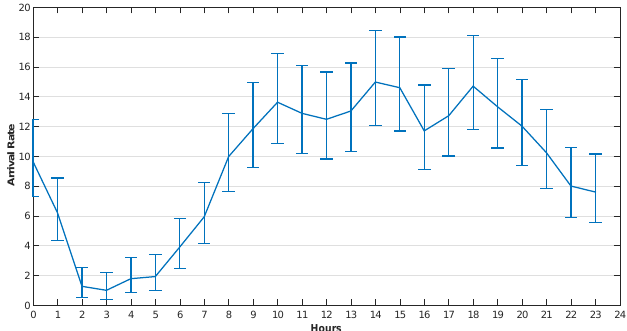
Figure 5. The Arrival Rate in 24 h, Square id 1000, Trentino, 1 November 2013.